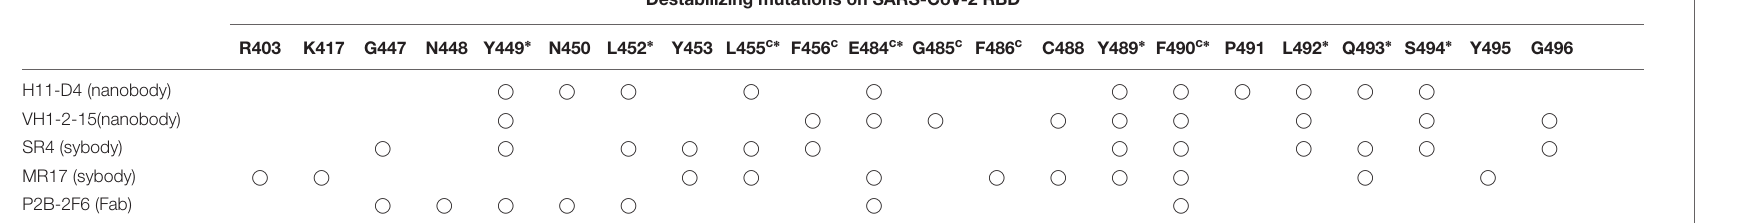
Destabilizing mutations on SARS-CoV-2